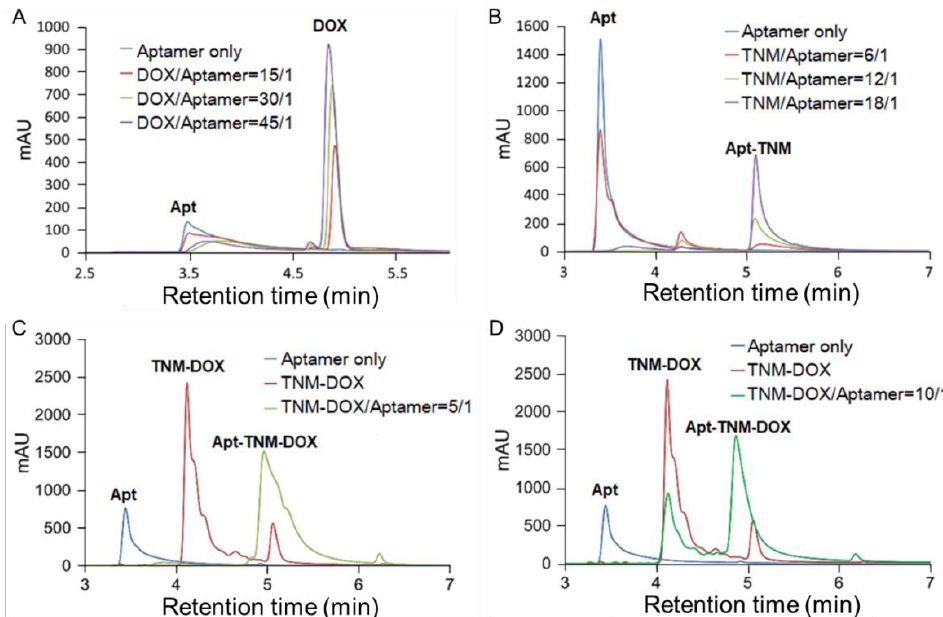
Figure 4. TNM structure mediates self-loading of a high drug payload into aptamer sequences. ( A ) HPLC analysis of the ( A ) HPLC analysis of the aptamer-DOX complex. ( B ) HPLC analysis of TNM structure conjugated aptamer-DOX complex. ( B ) HPLC analysis of TNM structure conjugated with aptamer sequences. ( C and D ) HPLC anal- with aptamer sequences. ( C , D ) HPLC analysis of aptamer–TNM–DOX conjugate formation at molar ysis of aptamer – TNM – DOX conjugate formation at molar ratios 5:1 and 10:1 of TNM-DOX to aptamer, respectively. Ap- ratios 5:1 and 10:1 of TNM-DOX to aptamer, respectively. Aptamer–TNM–DOX conjugates carried a tamer – TNM – DOX conjugates carried a high drug payload of 15 DOX molecules per aptamer sequence. high drug payload of 15 DOX molecules per aptamer